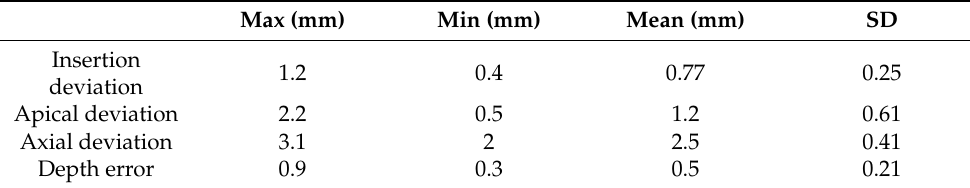
Table 2. Summary of results.